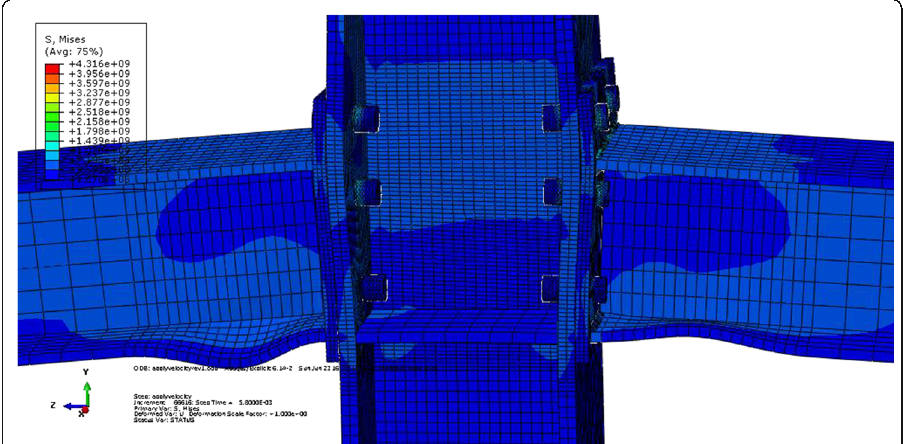
Fig. 14 Deformation of the joint region immediately prior to fracture in